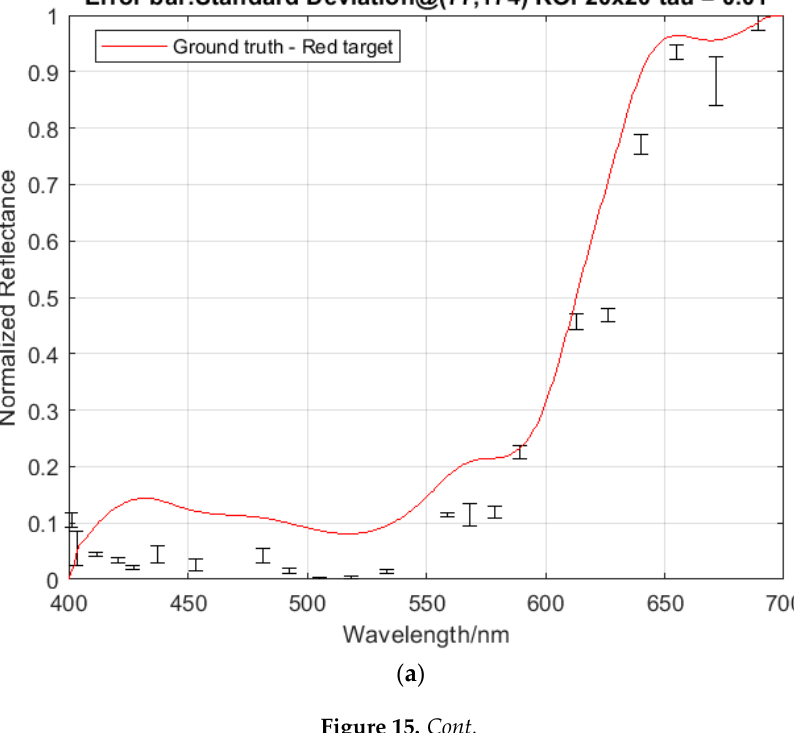
Figure 14. The effects of the tuning parameter τ in the TwIST algorithm for two wavelengths at 508.5 and 580 nm: ( upper panel ) τ = 0.1 and ( lower panel ) τ = 0.5. The aberration is stronger for larger τ .